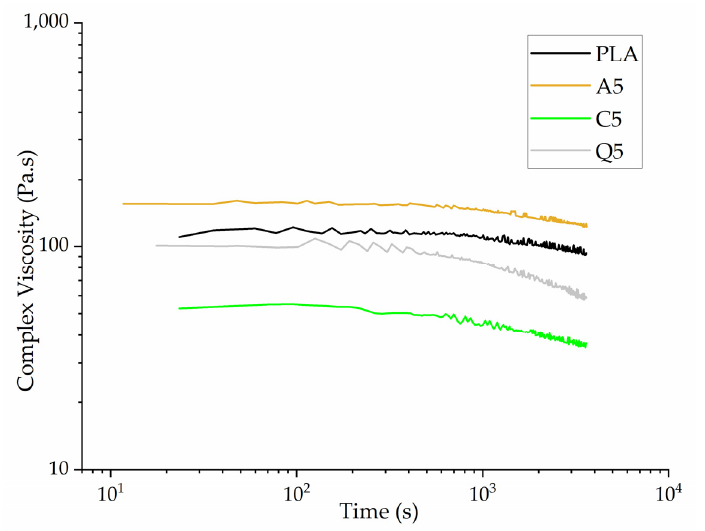
Figure 12. Isothermal rheogram of PLA and its composites containing 5% ( w / w ) of alizarin (A5), curcumin (C5), or quercetin (Q5).